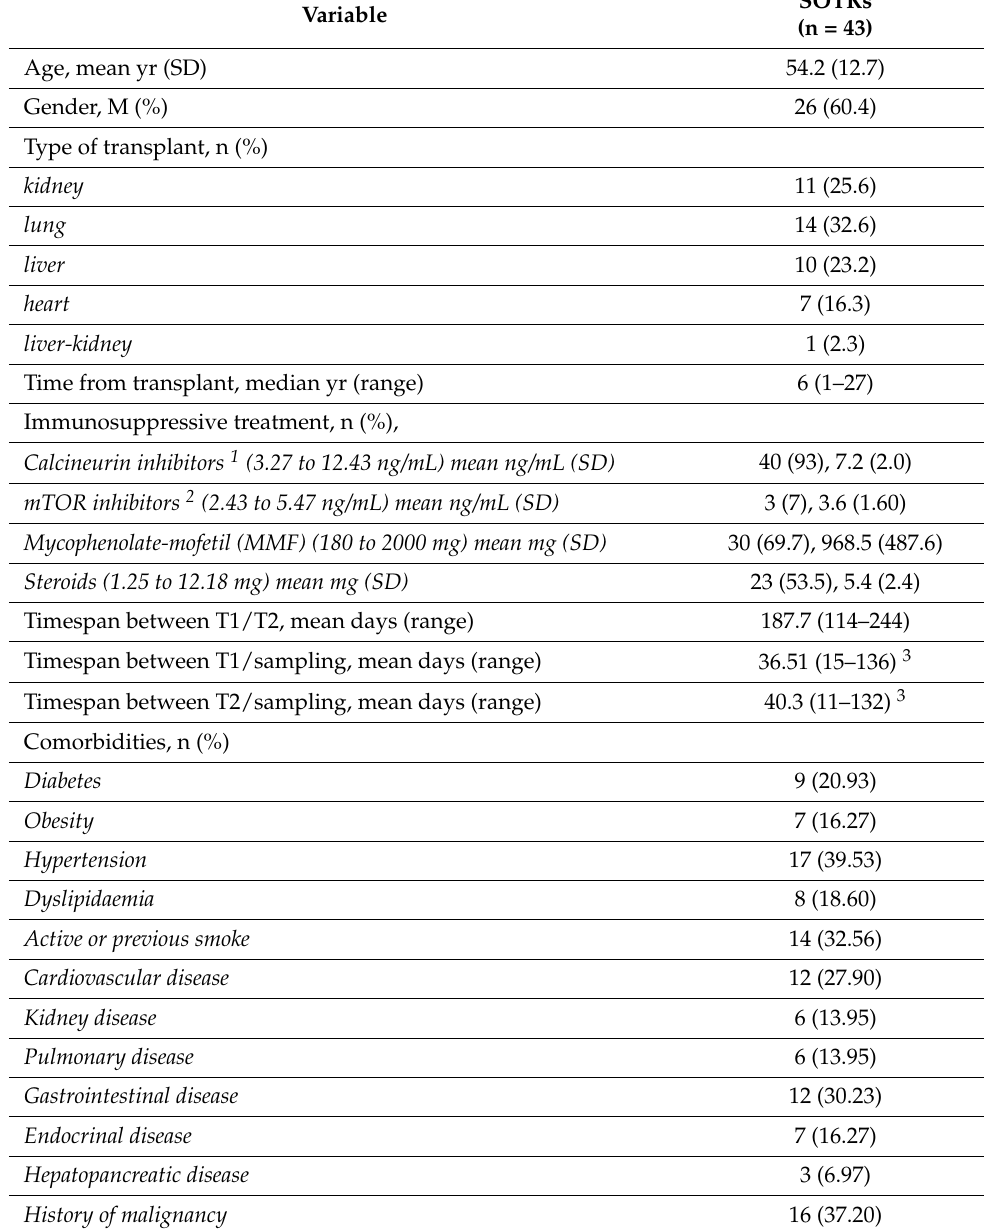
Table 1. Baseline characteristics of